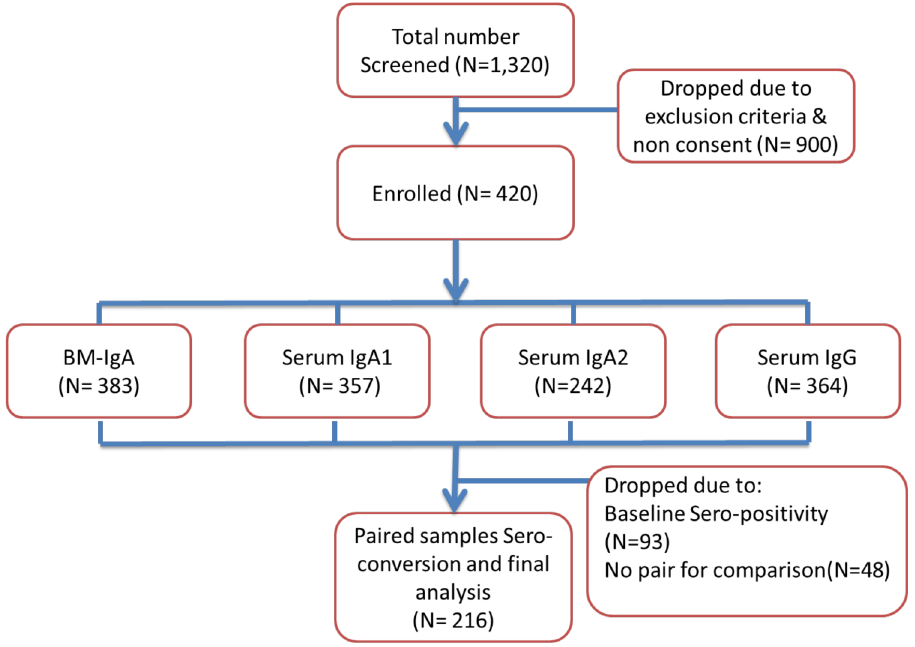
Fig 1. Study Participants Flow